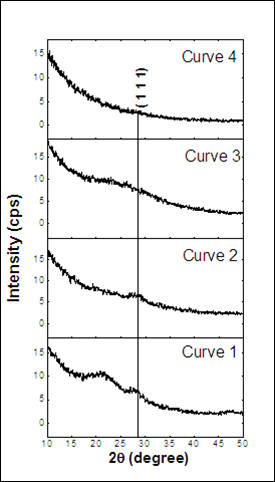
XRD spectra of annealed Si-based MLs. (curve 1) SiOx/SiO2 1 h, 1,100°C; (curve 2) SiOx/SiNy 1 h, 1,100°C; (curve 3) SiOx/SiNy 1 min, 1,000°C; and (curve 4) SiOx/SiO2 1 min, 1,000°C.